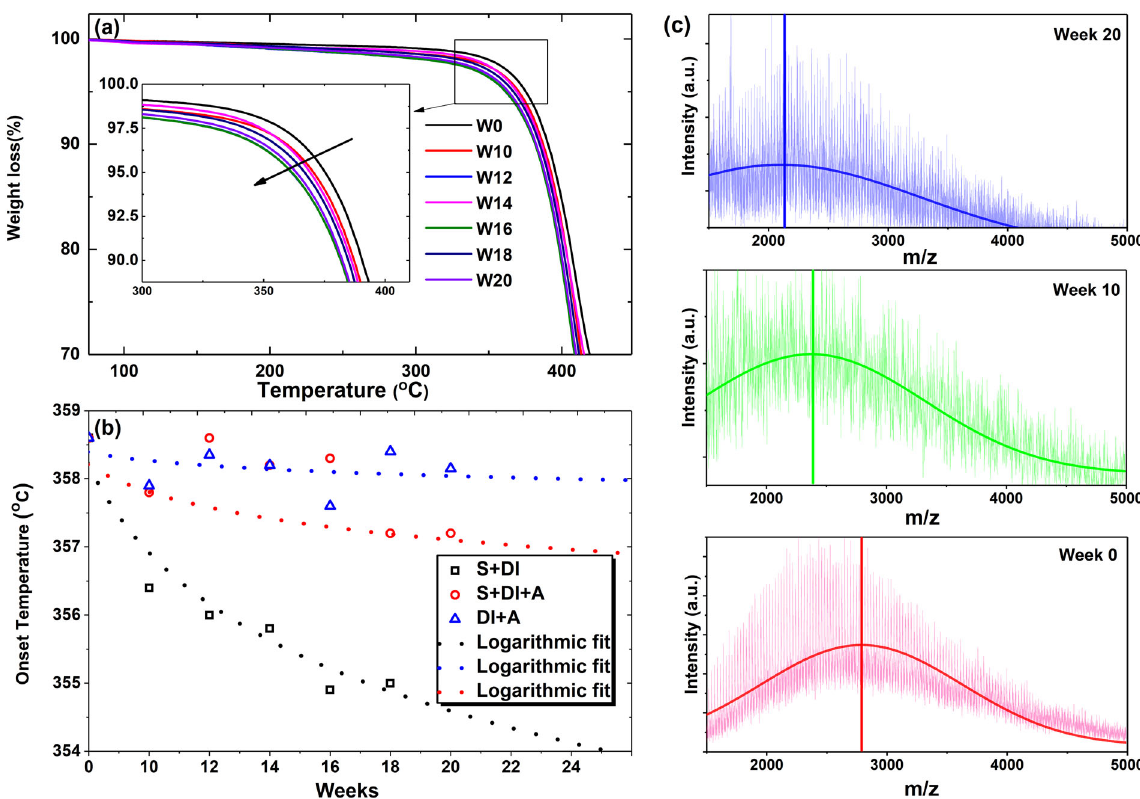
Fig. 3 TGA and MALDI-TOF mass spectra of carbon fi ber-reinforced vinyl ester composites. a Representative TGA weight loss (%) graphs with temperature for carbon fi ber-reinforced vinyl ester composites in soil solution with deionized water (S + DI), b graph of onset decomposition temperature (logarithmic fi t) in different environments: autoclaved soil solution with deionized water ( = − S + DI + A), soil solution with deionized water (O-S + DI), and autoclaved deionized water ( Δ -DI + A), measured at different exposure time periods. c MALDI-TOF mass spectra of carbon fi ber-reinforced vinyl ester composites in soil solution with deionized water (S + DI) indicating a reduction in average molecular weight with time at 2793, 2364, and 2138 g mol − 1 corresponding to weeks 0, 10, and 20 (bottom to top fi